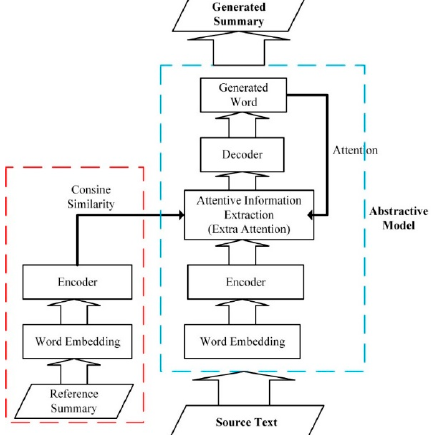
Figure 2. The flow diagram of our model. At the training stage, the Generated Summary in the figure does not exist. Our target is to train an abstractive model, namely, the part drawn by the blue dotted line. At the test stage, our input is only the source text and the part represented by the red dotted line does not exist, the output is the summary generated using the abstractive model.